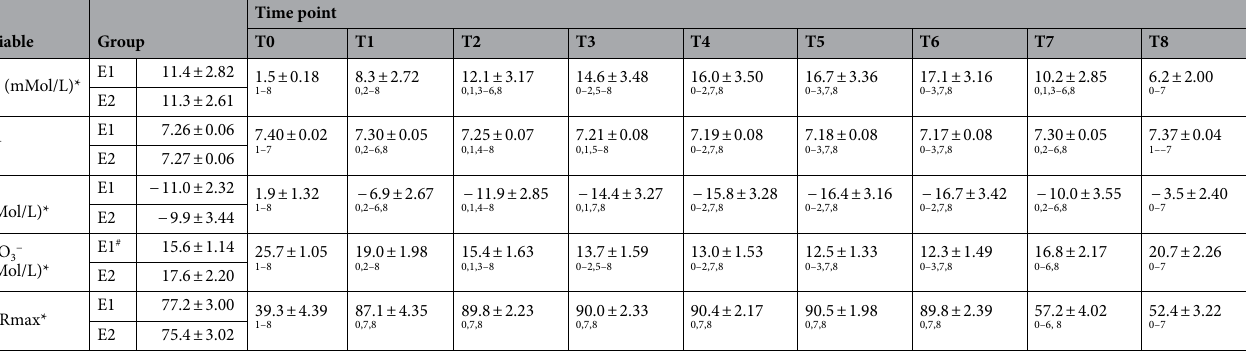
Table 4. Time and group effect for indicators characterizing internal training loads during SSGs in both groups of tested youth soccer players. Values characterizing groups and time points are presented